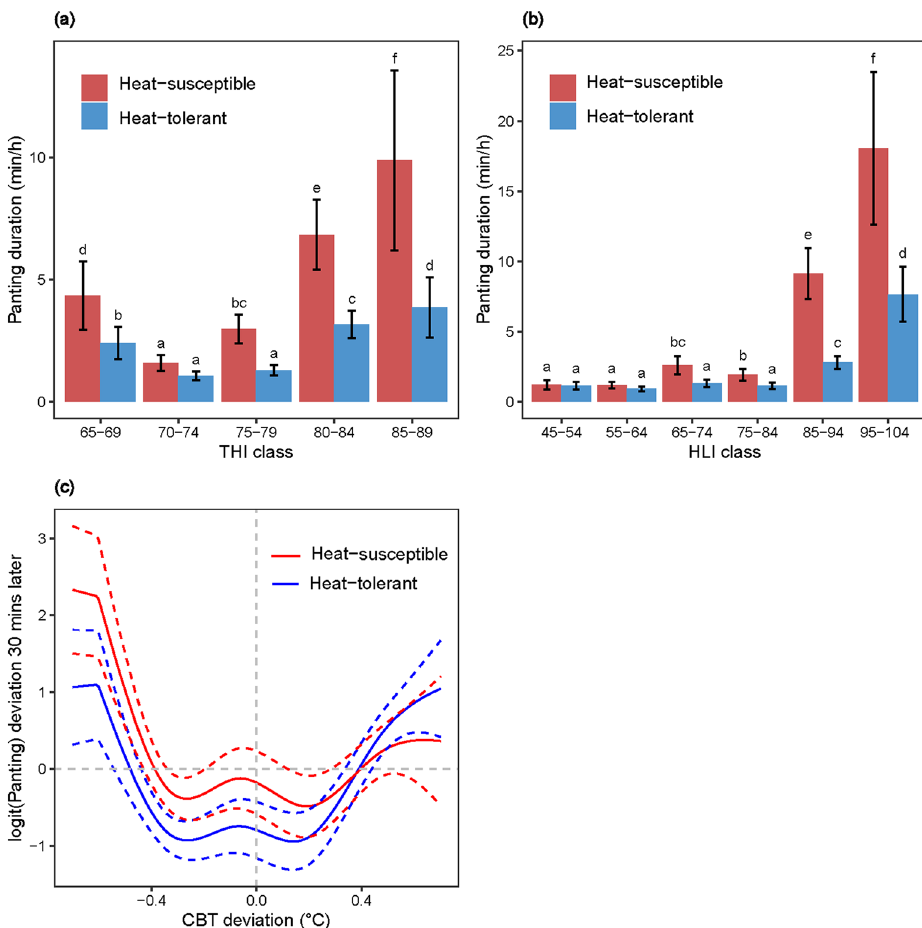
Figure 5. Panting response to different THI/HLI classes (based on raw data) ( a ) and ( b ) and to CBT deviations (based on decomposed time-series data) ( c ) for heat-tolerant and heat-susceptible cattle. Error bars in ( a ) and ( b ) indicate standard errors of mean (SEM) and the means with different letters differ significantly. The dotted lines in ( c ) indicates 95% confidence intervals of the panting response curves as determined from decomposed CBT and panting time-series data. Logit function was used as panting was recorded at minute level as a binary (Yes = 1, No = 0)